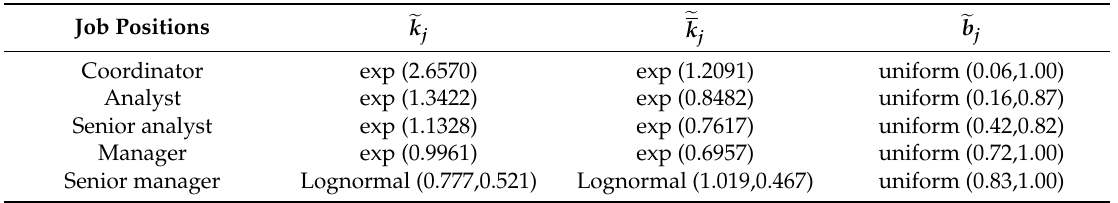
Table 4. Characterization of PDFs of stochastic